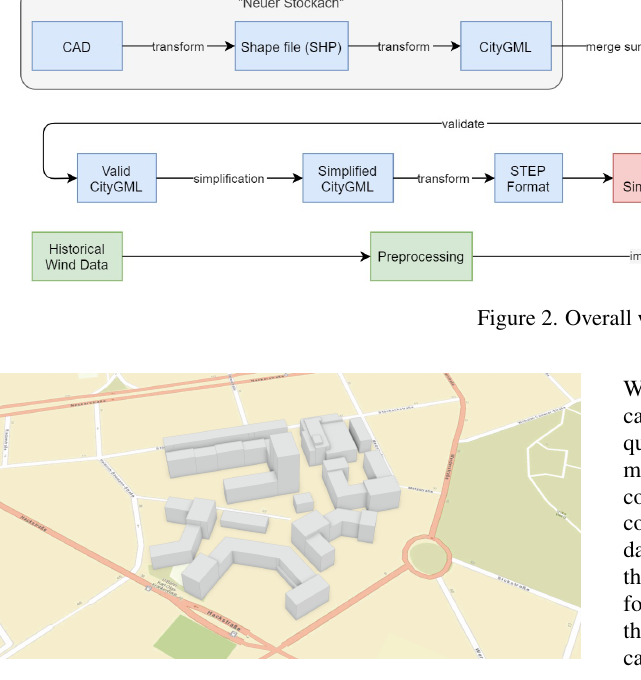
Figure 3. CityGML LoD1-model of the ”Neuer St¨ockach“ quarter in Suttgart.